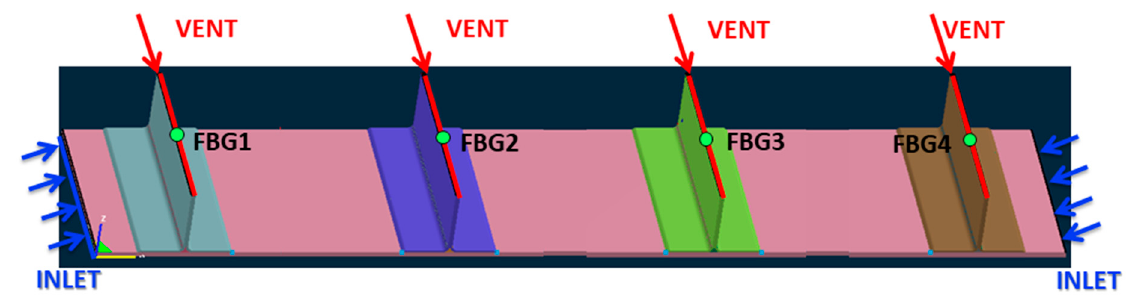
Figure 10. Resin inlets (blue arrows) and vents (red arrows) configuration.